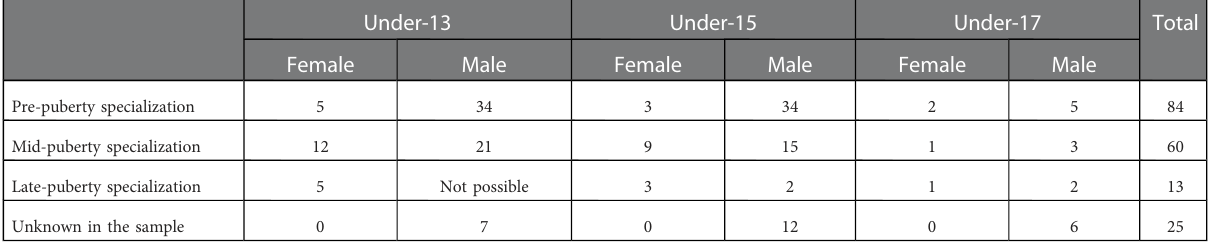
TABLE 2 Distribution Of players by the onset of specialization within an age group and sex in the sample of young Brazilian